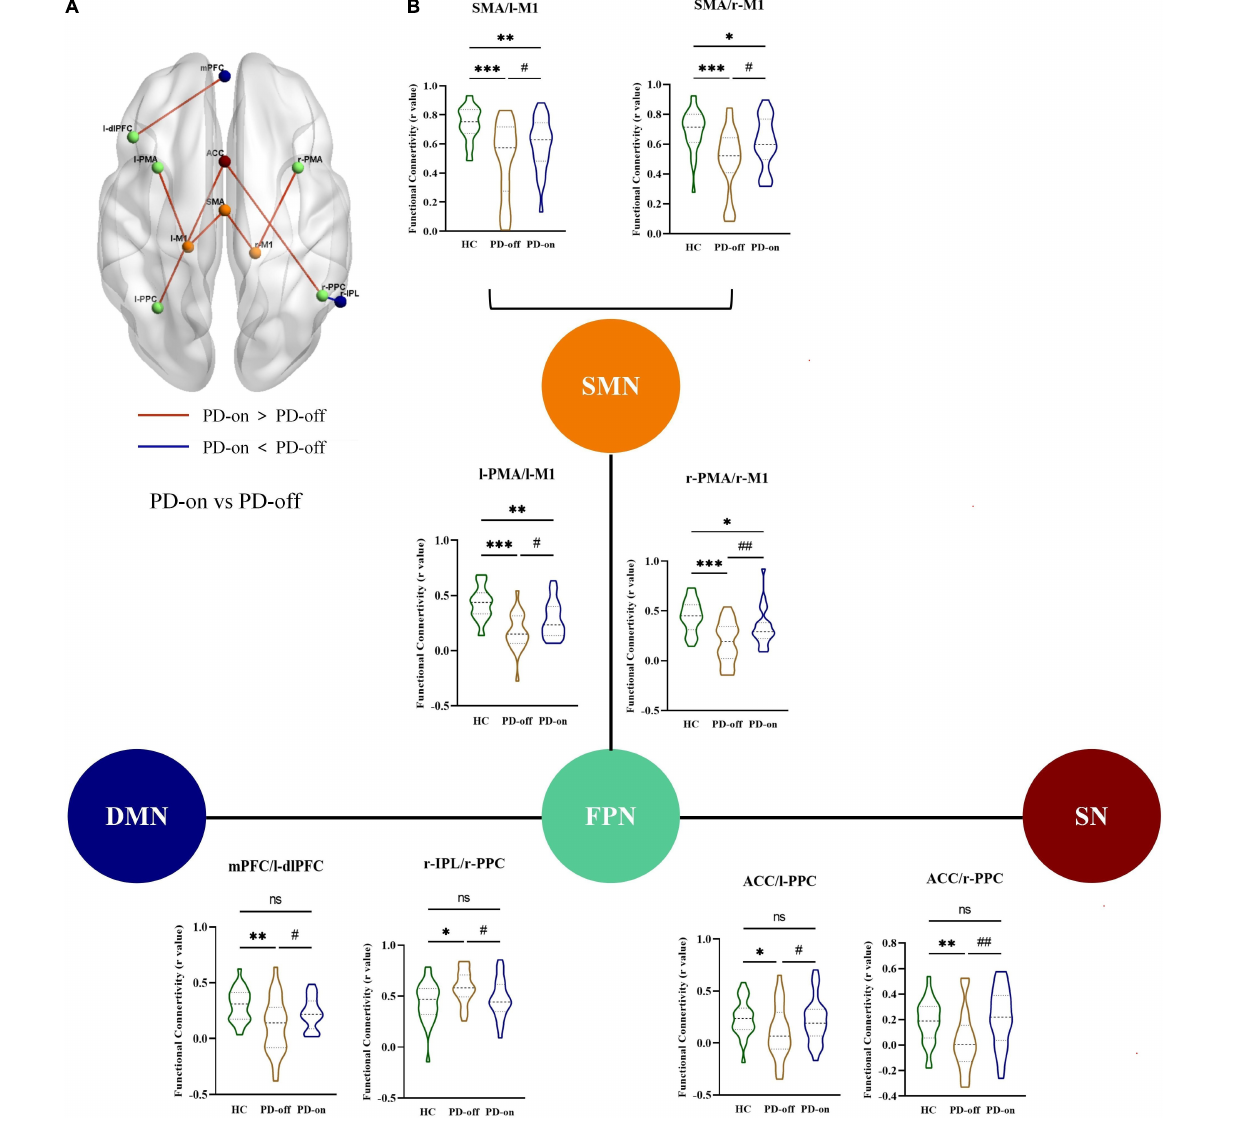
FIGURE 4 | DBS reversed the abnormal functional connectivity in patients with PD. (A) Interstate analyses of abnormal functional connectivities. The connections shown in light red represent PD-on > PD-off; dark blue connections refer to PD-off > PD-on. (B) Additionally, these results were presented in the violin graph among the networks. The bars represent the median (Q1, Q3). ∗ , # P < 0.05; ∗∗ , ## P < 0.01; ∗∗∗ P < 0.001 ( ∗ compared with controls, # compared with